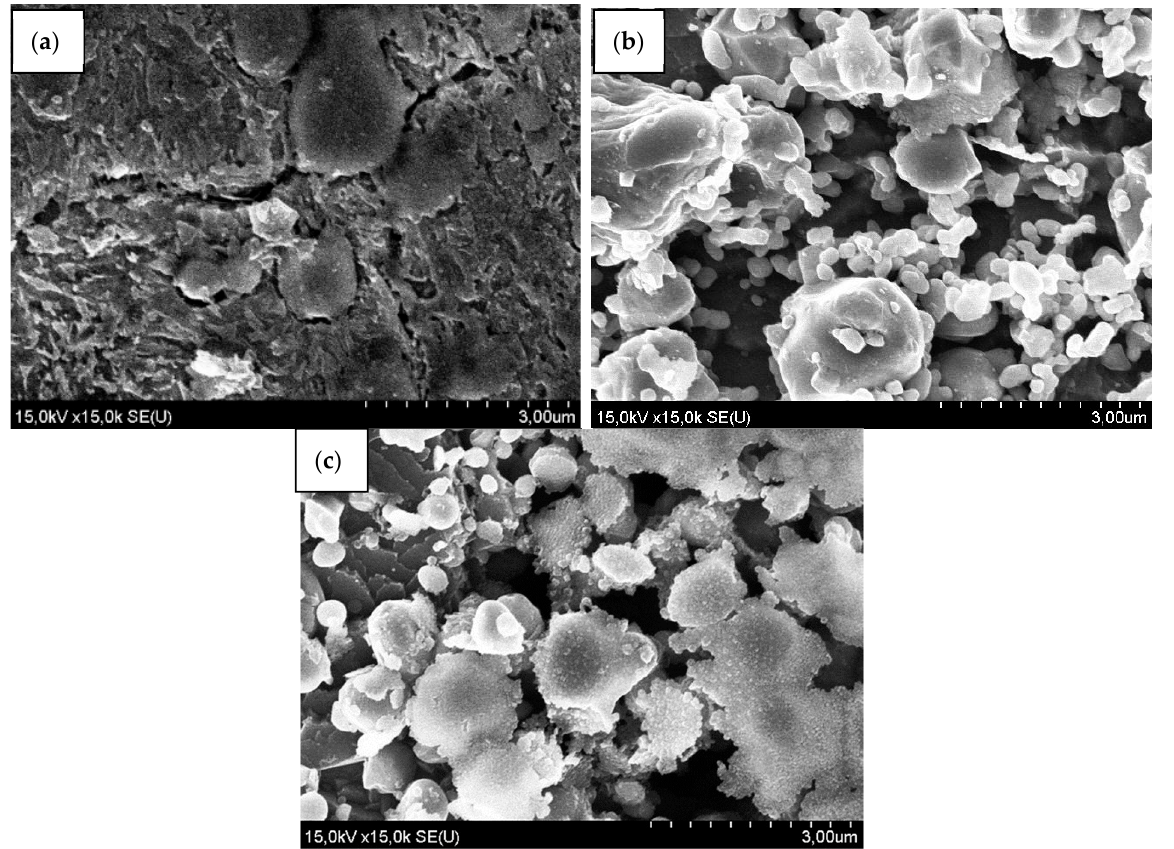
Figure 12. The structure of W6Mo5Cr4V2 steel ( a ) W6Mo5Cr4V2 steel microstructure without dynamic alloying after hardening, ( b ) W6Mo5Cr4V2 steel microstructure after dynamic alloying in the SDP mode by TiCN + Ni stream and hardening, ( c ) W6Mo5Cr4V2 steel microstructure after dynamic alloying in the SDP mode by TiCN + Ni stream, forging and hardening.